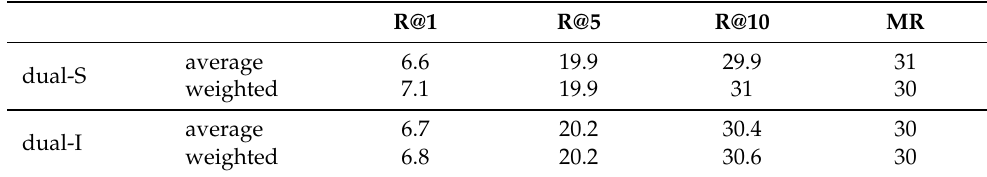
Table 4. Performance comparison on similarity aggregation using the average or the proposed weighted